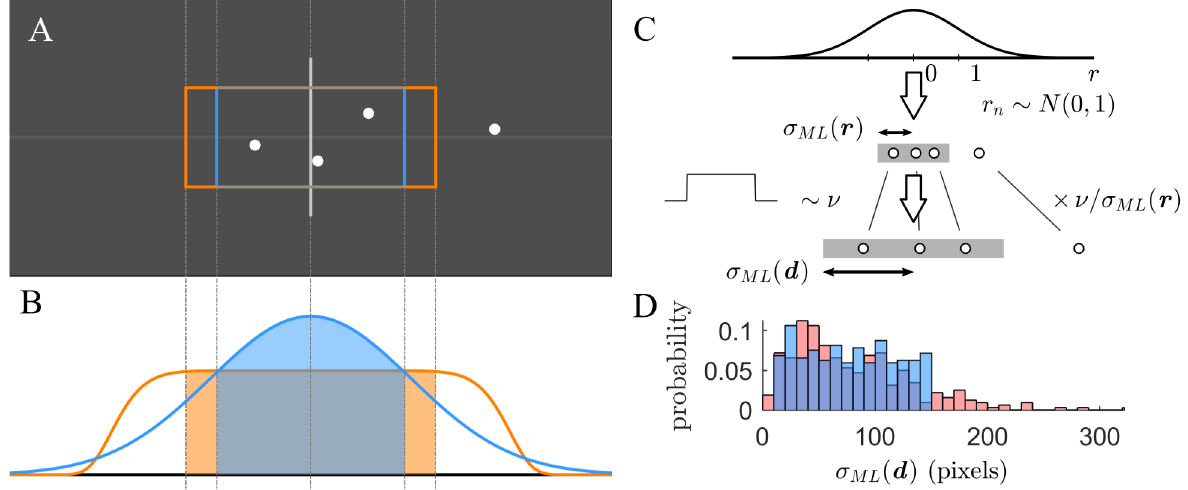
Fig 1. Human participants perform a task consisting in estimating the dispersion of future events based on a few observations. (A) Schematic of one trial of the task. Participants were asked to judge the unknown accuracy of a “dart player” to hit the center of the board (gray rectangle). Based on the four observed “darts” (white dots), participants must predict where future darts might strike the board. Specifically, participants were asked to capture 65% of all future imaginary darts by adjusting the width of the rectangular frame (colored frames, see below). Only the horizontal dispersion of the dots is relevant to estimate the accuracy of the dart player, while vertical displacements are added just to improve visibility of the samples. (B) Based on the observed samples, the participant might infer a predictive probability distribution over the position of the next sample. Two hypothetical predictive distributions are shown, representing different structural assumptions about how the samples might have been generated, corresponding to maximum likelihood estimation based on a Gaussian distribution (blue) or a generalized normal distribution with shape parameter p = 10 (orange) (see Methods). Based on the predictive probability distribution, the participant can set the frame’s width so that it matches the target percentage of 65% (colored frames in panel A). Note that for the assumption of a generalized normal distribution, the posterior is more sensitive to data points far from the center and hence a larger frame is chosen. (C) The horizontal positions of the points with respect to the center were generated as follows. First, all samples r = (r 1 , ... , r 4 ) were generated independently from a standard normal distribution. Second, the p ffiffiffiffiffiffiffiffiffiffiffiffiffiffiffiffiffiffi P samples were scaled by the factor ν / σ is the maximum likelihood estimator (MLE) for a normal distribution ( r ), where s ð r Þ ¼ 1 = N r 2 ML ML n centered at zero and ν is drawn from a uniform probability distribution over the range of [10,140] pixels. The scaled samples d = ν / σ ML ( r ) (cid:1) r feature p ffiffiffiffiffiffiffiffiffiffiffiffiffiffiffiffiffiffi P ¼ n . This method allows choosing any desired distribution of σ ML ( d ) by setting ν correspondingly. (D) 1 = N d 2 n Histogram of σ ML ( d ) across 320 trials (blue). For comparison, the red histogram indicates the results for a sample scaling d = ν (cid:1) r without normalizing by σ ML ( r ). Both samples have a comparable mean, but the red distribution features few but extremely outlying values, which are avoided by our scaling